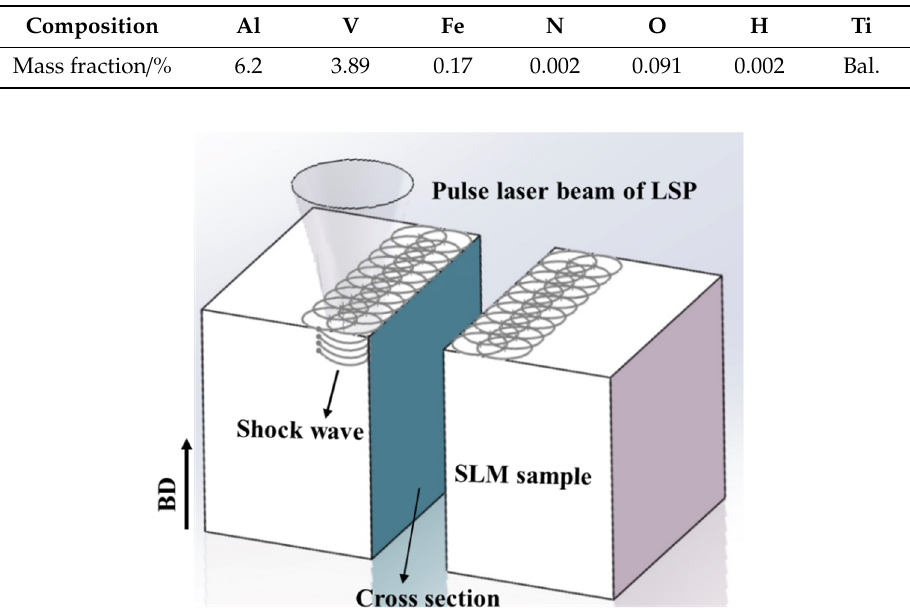
Figure 1. Schematic of the laser shock peening (LSP) principle for a selective laser melting (SLM)